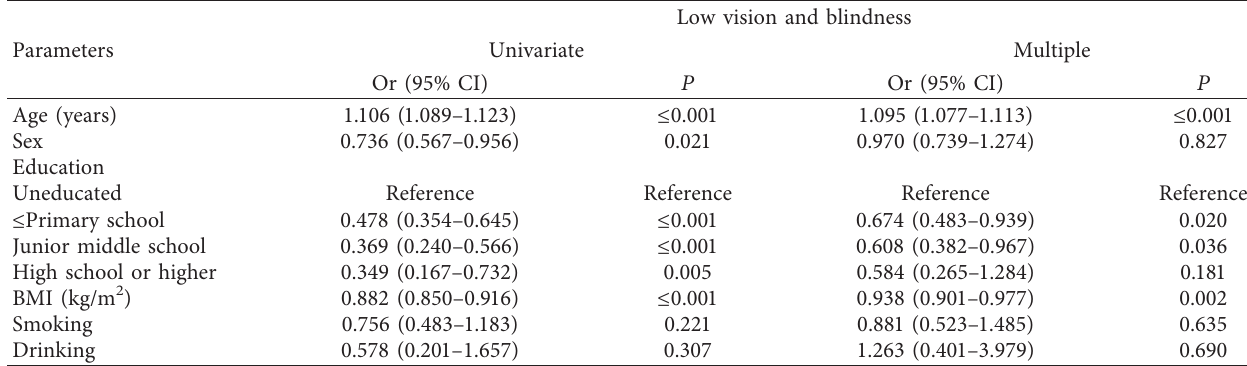
Table 4: Univariate and multiple logistic regression analysis of risk factors associated with low vision and blindness.